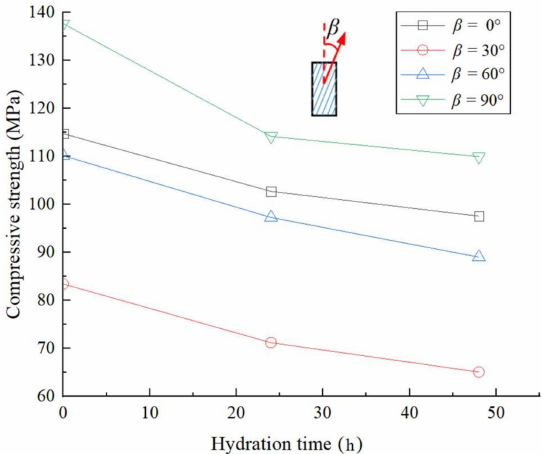
Figure 7. Compressive strength (deviatoric stress) of the lamellar shale samples under confining pressure of 15 MPa changed with hydration time.